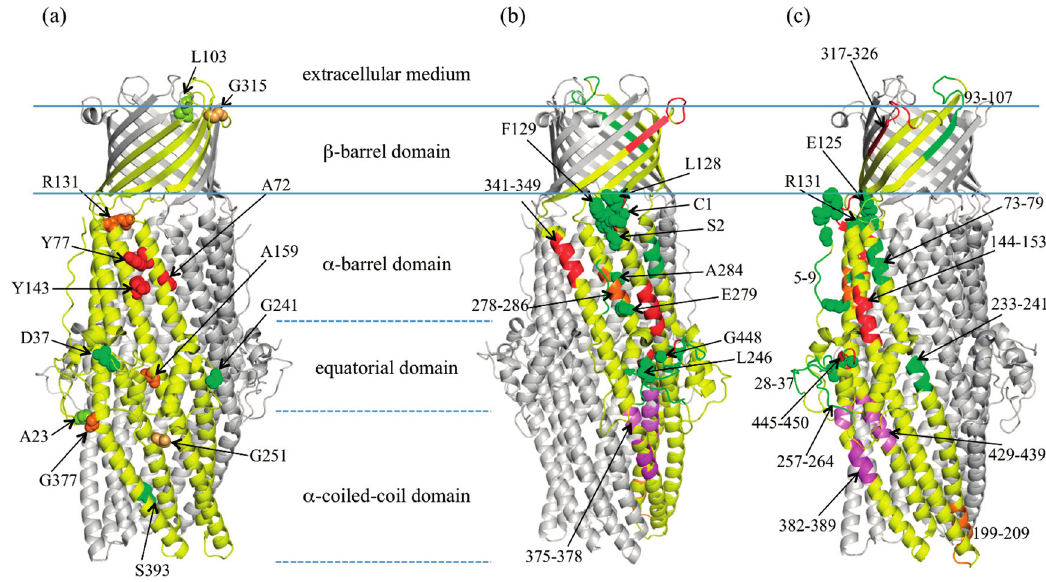
Figure 1. OprM structure with reported mutagenesis studies ( a ) the point of insertion of the malarial epitope performed by Wong [50] are presented in balls of different colors from red to green following the functional consequence on resistance. Red: protein not expressed or with resistance comparable to the OprM-inactivated strain; green: protein as active as the wild type (wtOprM); ( b and c ) two different views of OprM structure with mutations and deletions reported in [51] (same colour code as in ( a )) and deletion studied in [50,52] that lead to important functional modifications when compared with wtOprM (colored in